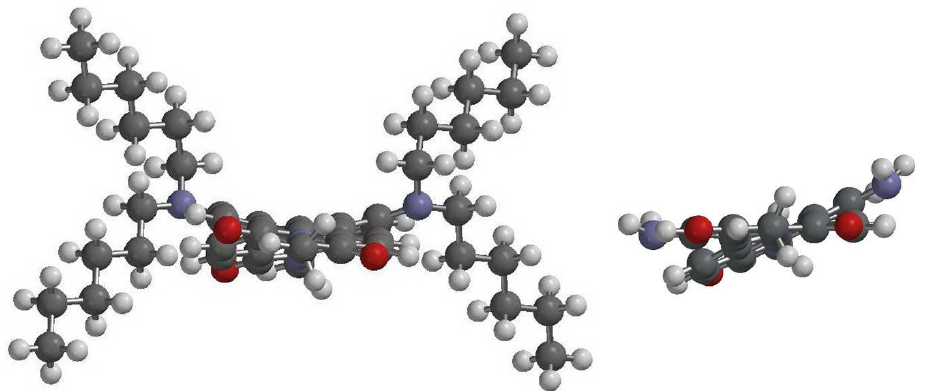
Figure 7. DFT (B3LYP/6-31G**) geometry-optimized structures of 1a (left) and 2 (right) shown with view along the long axis. For computational purposes, methyl groups replace the cyclohexyl groups at the imide positions.